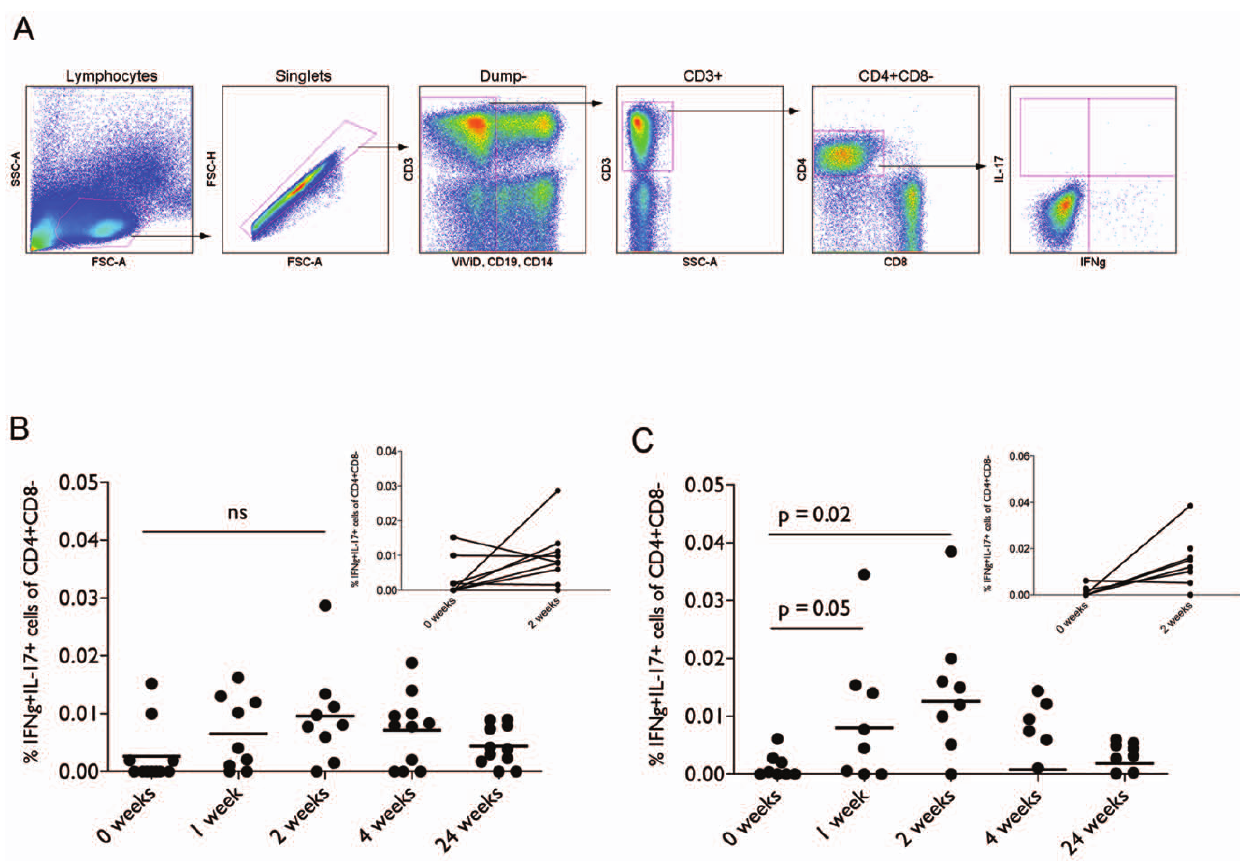
Figure 2. IL-17 and IFN- c production in PBMC peaks 2 weeks post-vaccination. PBMC from vaccinated subjects were stimulated with Ag85A peptide pools with or without 100 uM ARL67156. No stimulation and phorbol 12-myristate 13-acetate with ionomycin were used as negative and positive controls. Percentages shown are unstimulated subtracted from Ag85A stimulation. Following staining, cells were gated as shown in (A): Lymphocytes were gated for on FSC vs. SSC. Singlets were then gated and dead cells, B cells and monocytes were gated out. CD3 + cells were selected for CD4 + CD8 2 cells. Antigen-specific cytokine expression from these cells was evaluated. Cells expressing both IL-17 and IFN- c were quantified and shown in (B). The effect of ARL67156 on cytokine expression was investigated by addition during ICS stimulation (C).